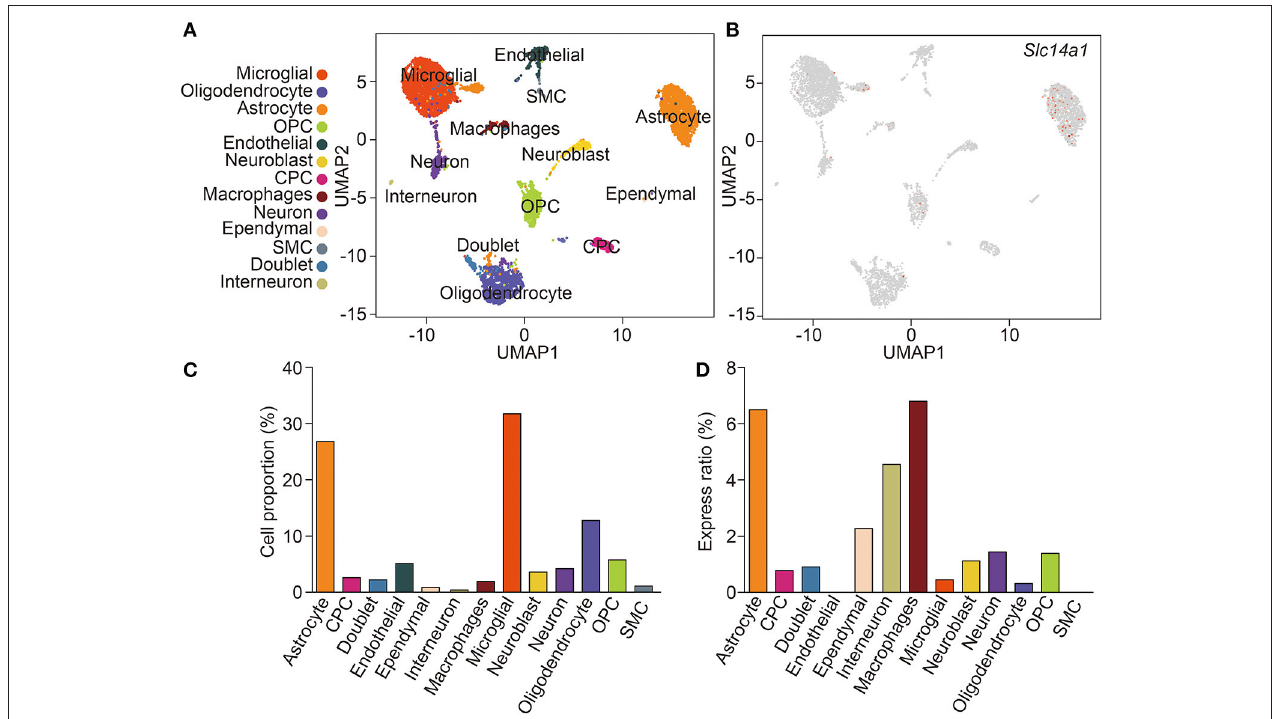
FIGURE 1 | scRNA-seq analysis of wild-type mouse brain. (A) Unsupervised clustering uniform manifold approximation (UMAP) plot of CNS cell of wild-type mice. OPC, oligodendrocyte precursor cells; CPC, choroid plexus cells; SMC, smooth muscle cells ( n = 4,884). (B) Expression scatterplots of Slc14a1 in population from wild-type mice. (C) Cell proportion of CNS cell. (D) Express ratio analysis of Slc14a1 based on percentage composition.